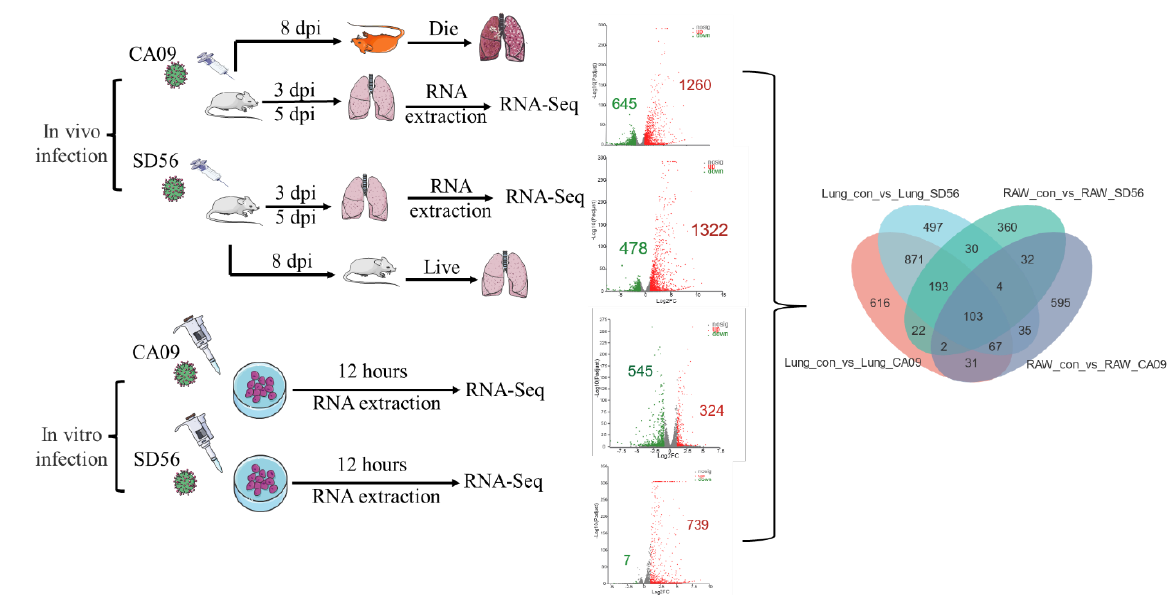
Figure 2. Sample processing procedures and global transcriptome changes. In the volcano plot, the splashes were for different genes, among which, grey dots represent genes with no significant discrepancy, red dots represent genes that were significantly upregulated, and green dots represent significantly downregulated genes. In the Venn diagram, the numbers indicate unique and common DEGs in four groups.